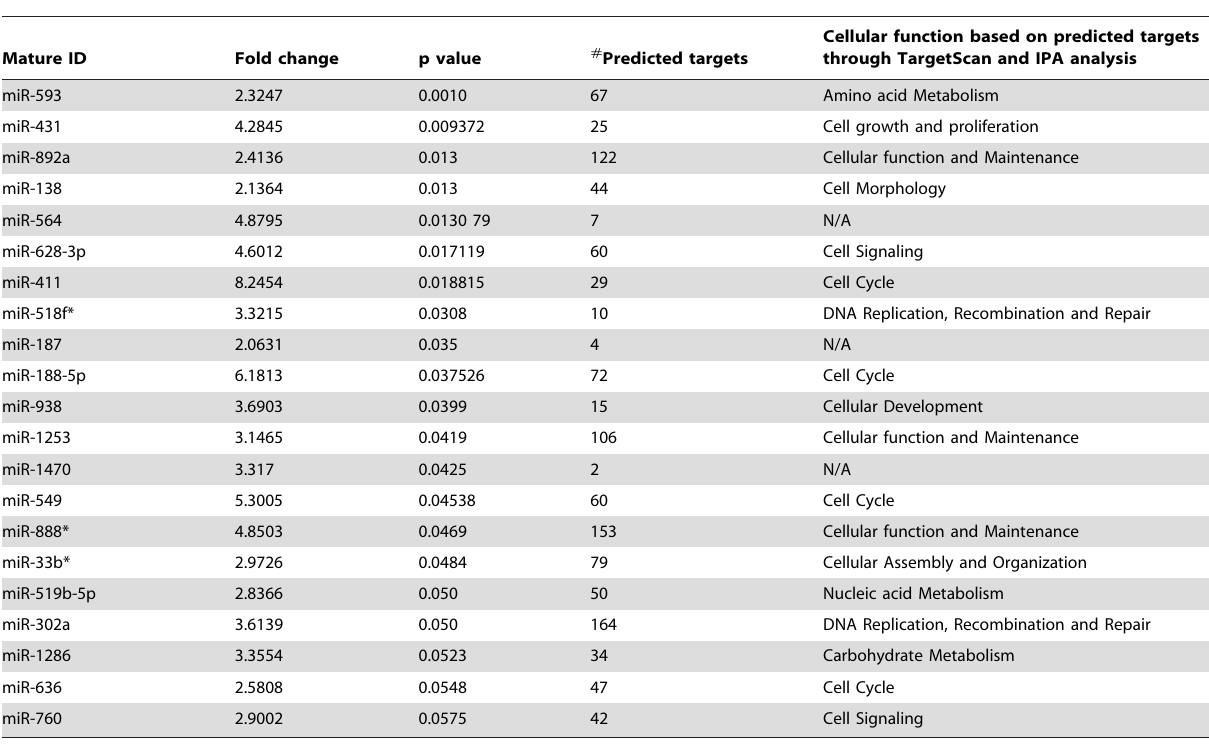
Table 2. Significantly regulated miRNAs in HIV-1 infected cultures compared to uninfected control cells.